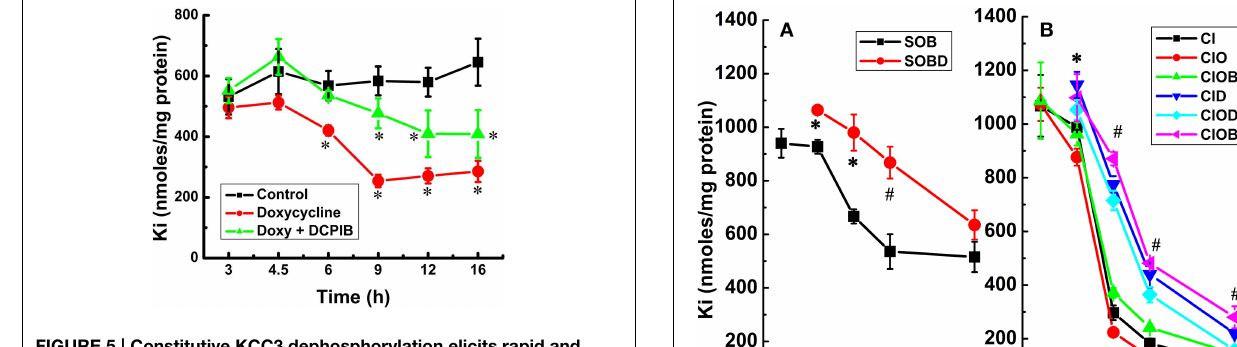
FIGURE 5 | Constitutive KCC3 dephosphorylation elicits rapid and potent cellular K i loss, which is time-dependent and partially sensitive to DCPIB. K i content was measured as described in Materials and Methods during induction with doxycycline (1.0 µ g/ml) and in the presence and absence of DCPIB (50 µ M), an inhibitor of volume regulated Cl − channels (VRACs) and intermediate K + channels. Black squares, Control, i.e., no doxycycline or DCPIB; red circles, doxycycline alone, and green triangles, doxycycline + DCPIB. Time points where there was a significant change were compared vs. the Control. n = 8 individual determinations. Total number of independent identical experiments N = 2 . * p < 0 . 001 ; data represent the mean ± SEM values.